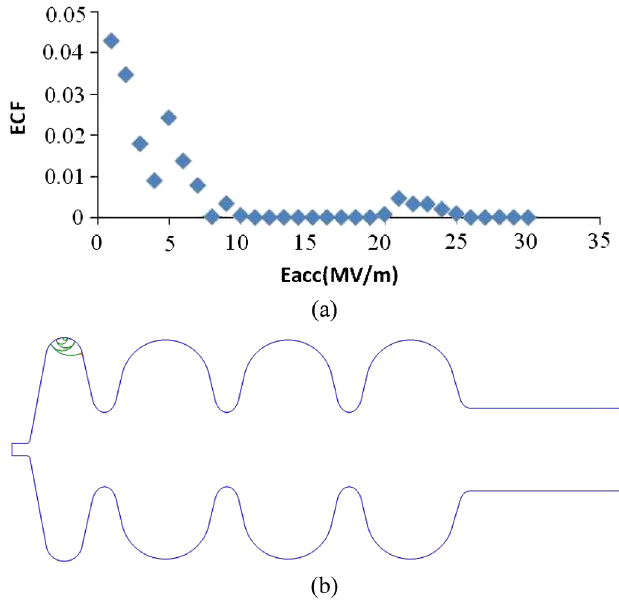
FIG. 4. (Color) Multipacting simulation (a) enhanced counter function. (b) Electron trajectory orbit at the first half